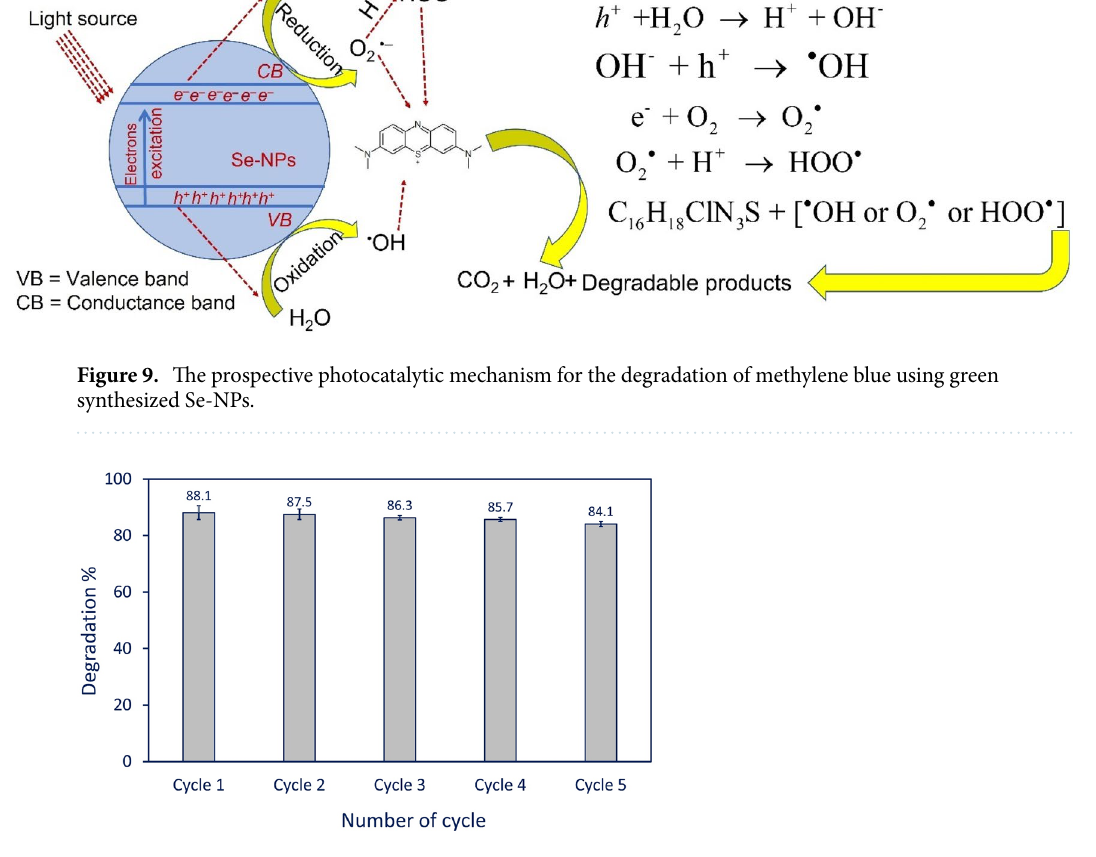
Figure 10. Reusability test of green synthesized Se-NPs for degradation of MB for five consecutive